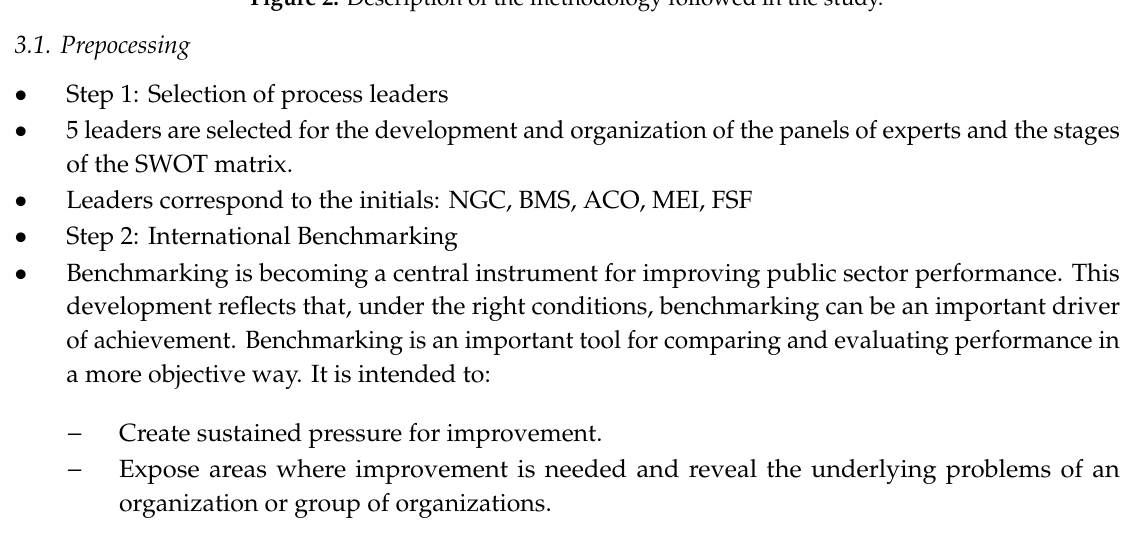
Figure 2. Description of the methodology followed in the study.